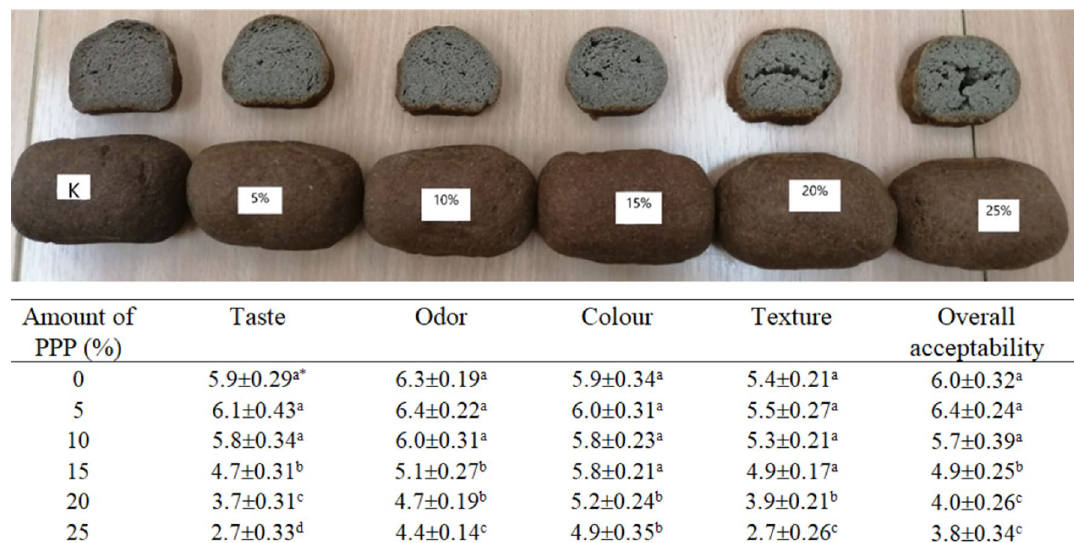
Figure 3. Overall view, and results of sensory evaluation of low-carbohydrate bread with the addition of 5% -25% pea protein powder (PPP) . The author of the photo in this figure is Monika